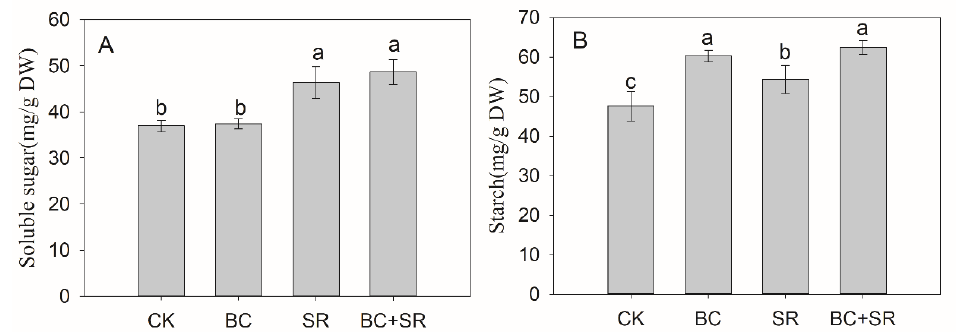
Figure 3. Effect of different soil types on soluble sugar ( A ) and starch ( B ). CK, sand only; BC, biochar; SR, sand and soft rock; BC + SR, sand, biochar, and soft rock. Data are shown in mean ± SD. Different letters indicate significant differences ( p < 0.05).